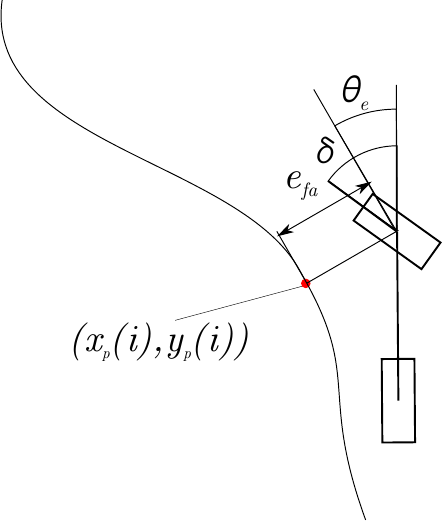
Figure 8. Stanley method steering